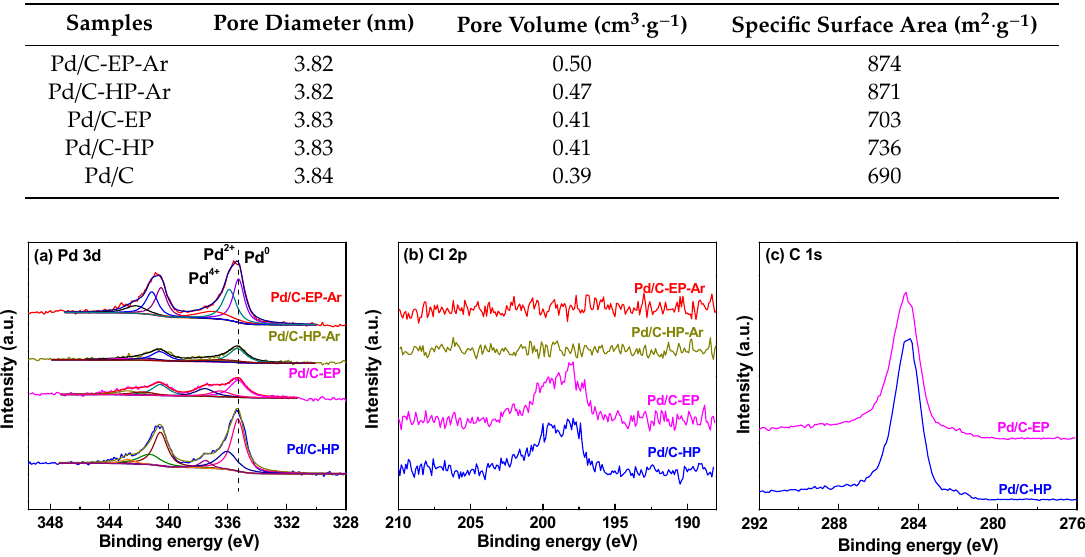
Table 1. Specific surface area, pore diameter, and pore volume of the Pd / C catalytic materials.